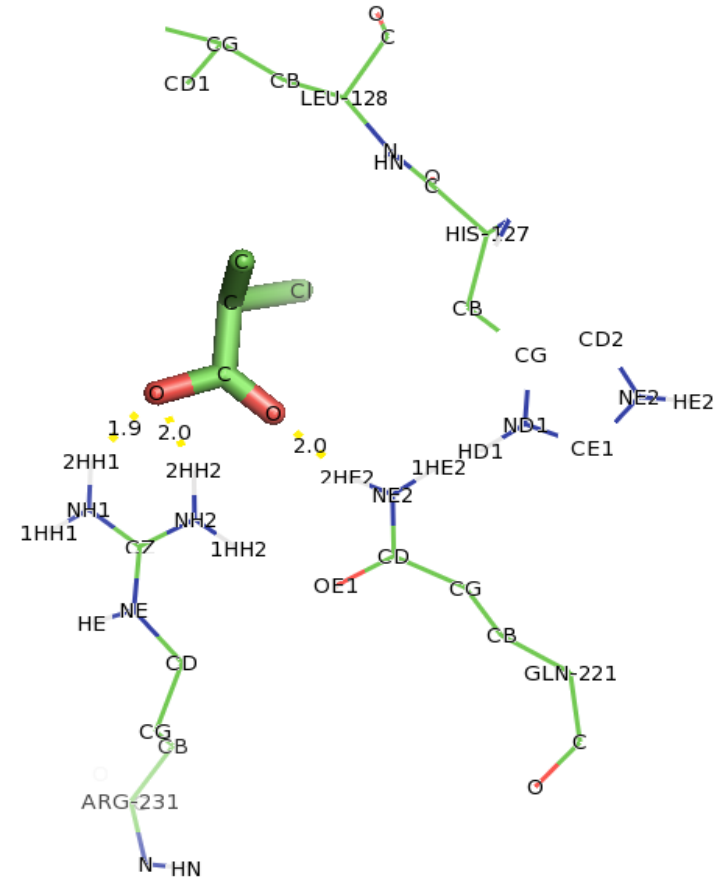
Figure 15. The interacting residues of DehD variant Y135A with D -2CP. Hydrogen bond distances are in